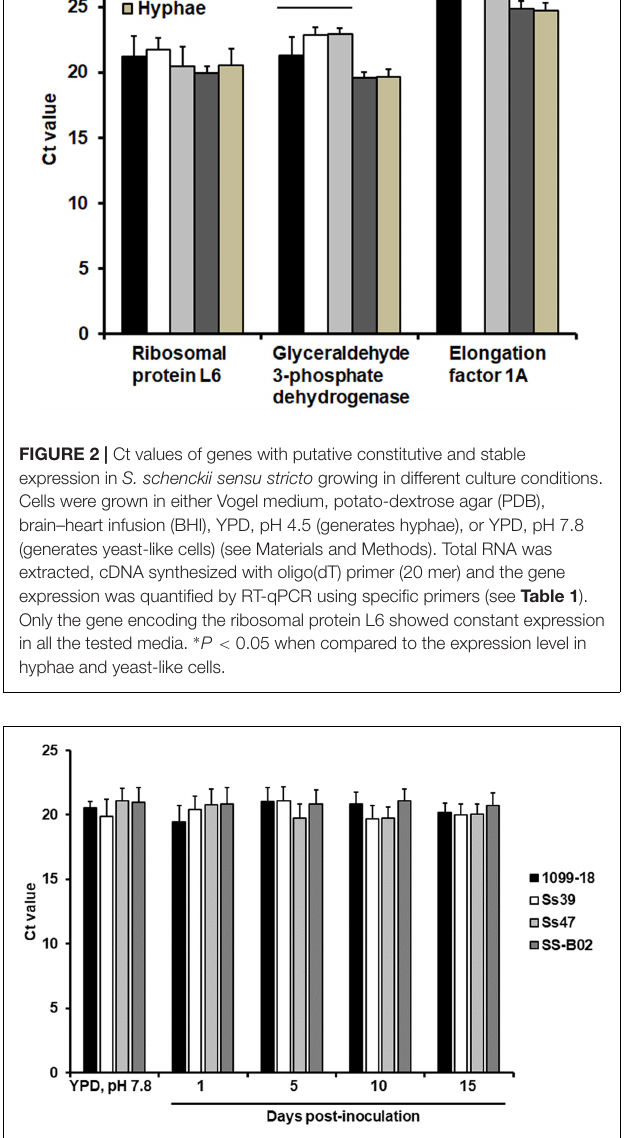
FIGURE 3 | Ct values of the S. schenckii sensu stricto gene encoding for the ribosomal protein L6 upon interaction with G. mellonella larvae. Sporothrix yeast-like cells were obtained in YPD broth, pH 7.8, and used to inoculate animal groups containing 10 larvae. Animals were kept at 37 ◦ C and decapitated either at days 1, 5, 10, or 15 post-inoculation. Fungal cells were retrieved from hemolymph, total RNA was extracted, cDNA synthesized with oligo(dT) primer (20 mer) and the gene expression was quantified by RT-qPCR using specific primers (see Table 1 ). One-way ANOVA was used to establish statistical significance. P -value was for all the strains > 0.05.